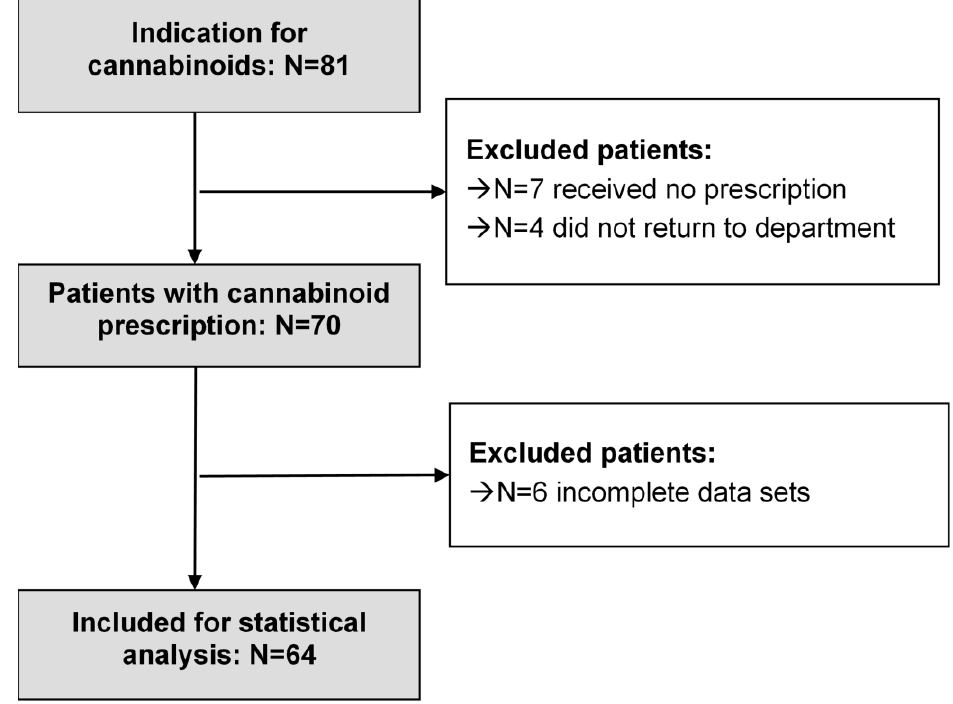
Figure 1. Flow diagram of the inclusion criteria.